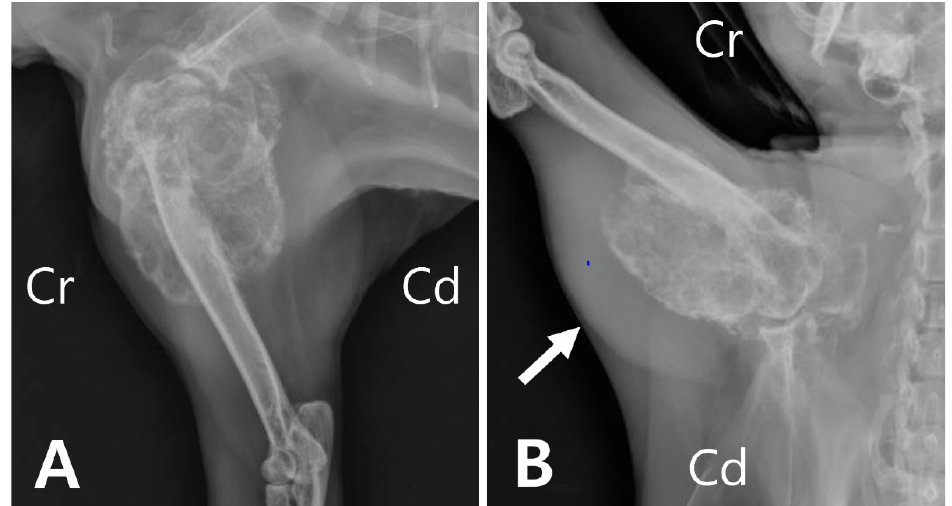
Figure 1. ( A ) A large expansile, lobulated mass of mixed osteolytic and osteoproliferative areas involving the proximal humerus. ( B ) Note marked soft tissue swelling around the lesion (arrow) of the humerus.